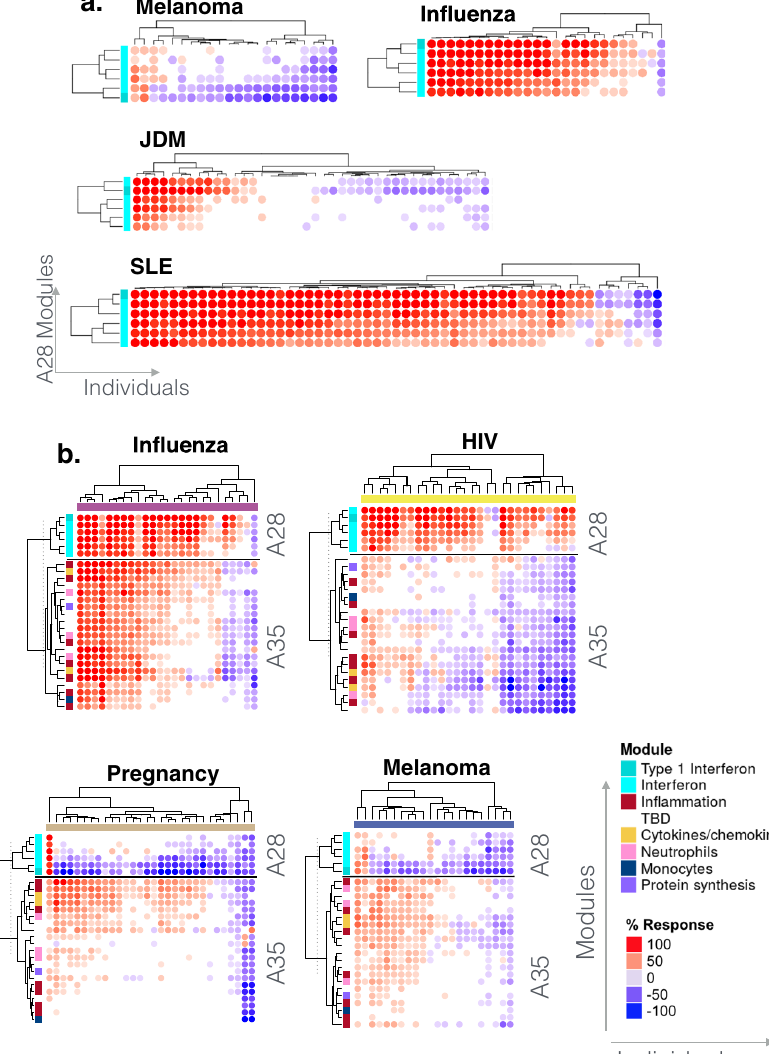
Fig. 9 Abundance patterns across individuals. a Changes in abundance for A28 modules. The heatmaps display the changes in abundance for the same six modules (rows) across individuals (columns) in four reference cohorts. The rows and columns on the heatmap are arranged based on similarities in abundance patterns. b Changes in abundance for A28 and A35 modules. The heatmaps display the changes in abundance of six modules constituting aggregate A28 and 21 modules constituting aggregate A35 (rows) across individuals (columns) in four reference datasets. Functional annotations associated with different modules are indicated by a color code and corresponding legend. The heatmaps can be accessed and exported for all 16 datasets and 38 module aggregates using the web application: https://drinchai.shinyapps.io/BloodGen3Module/ (under the “ MODULES X INDIVIDUALS ”